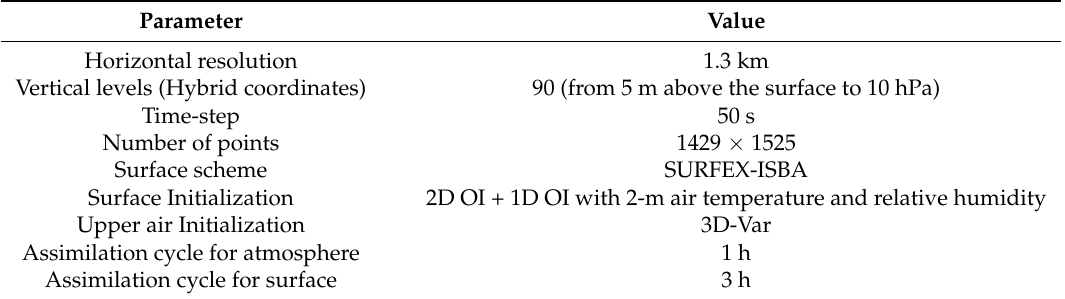
Table 1. The AROME-France model